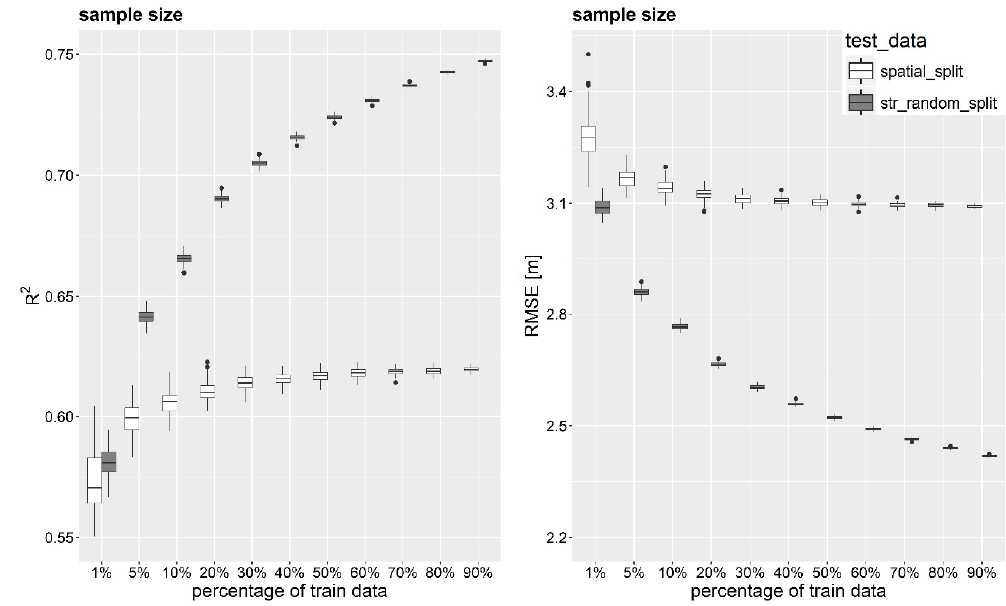
Figure 10. Impact of sample quantity on model prediction performance using “stratified random sampling” (dark-grey boxplot) and “spatial sampling” (white boxplot). With an increasing number of training samples, the model performance increases continuously for “stratified random sampling” and saturates for “spatial sampling”. 1% of training data corresponds to 1000 1-ha samples.